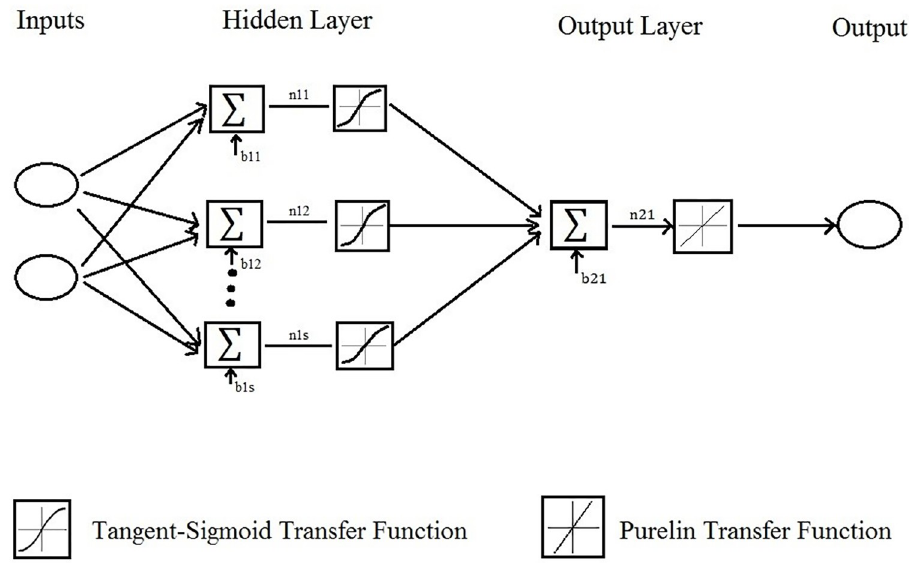
Fig 1. Structure of MLP ANN for modeling the microbial count. n, neuron; s, number of neurons; b, bias.